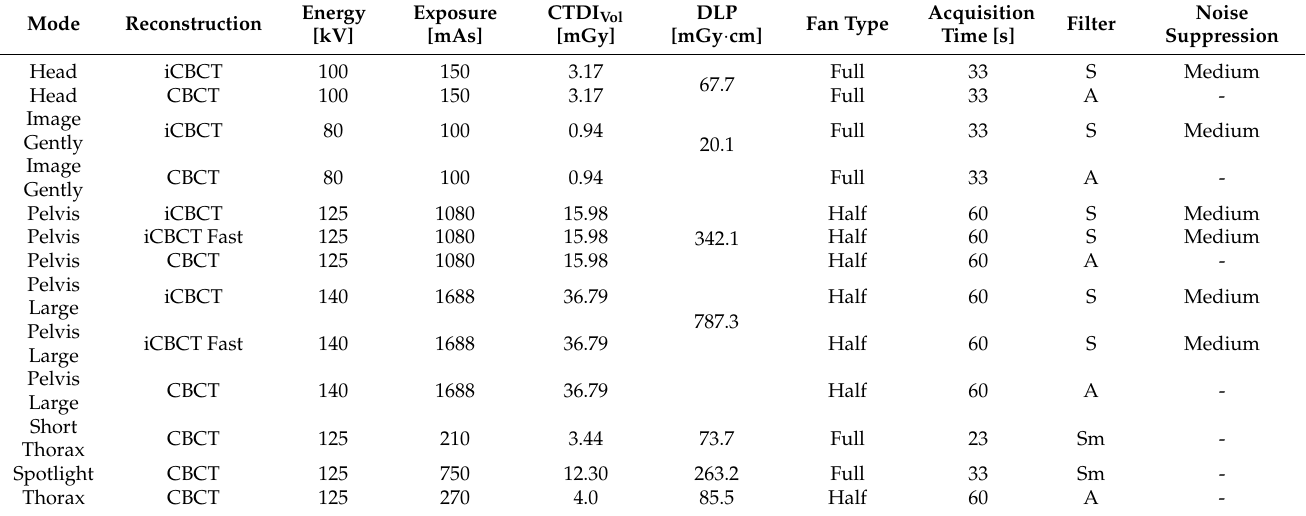
Table 2. CBCT and iCBCT acquisition parameters (extracted from the instrument) for the True- Beam accelerator (slice thickness = 2 mm; matrix size = 512 pixels; filter: S—Standard, A—Auto,